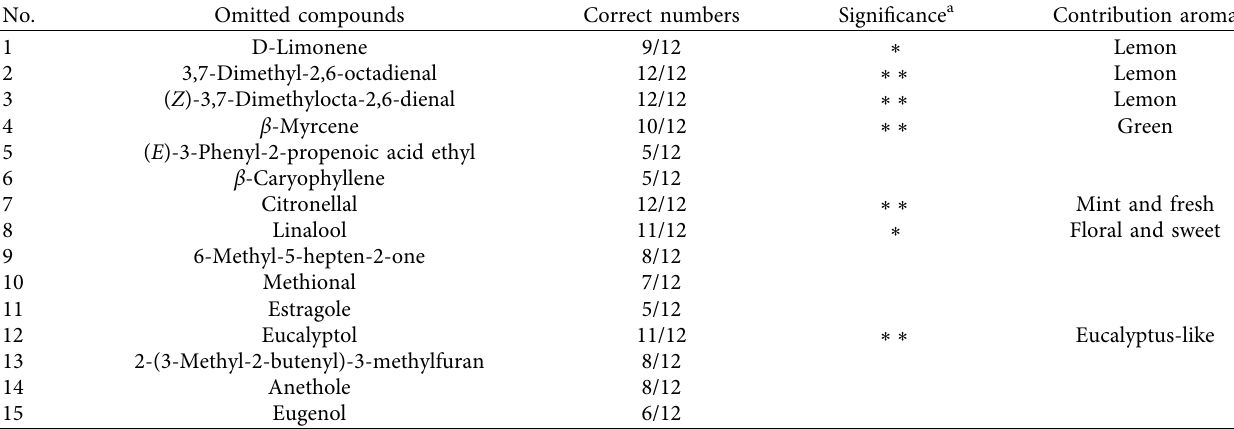
Table 2: Results of the addition